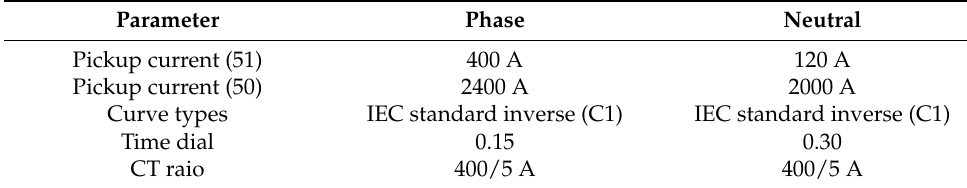
Figure 7. Substation test system. Table 2. Parametrization of 50/51 protection functions.